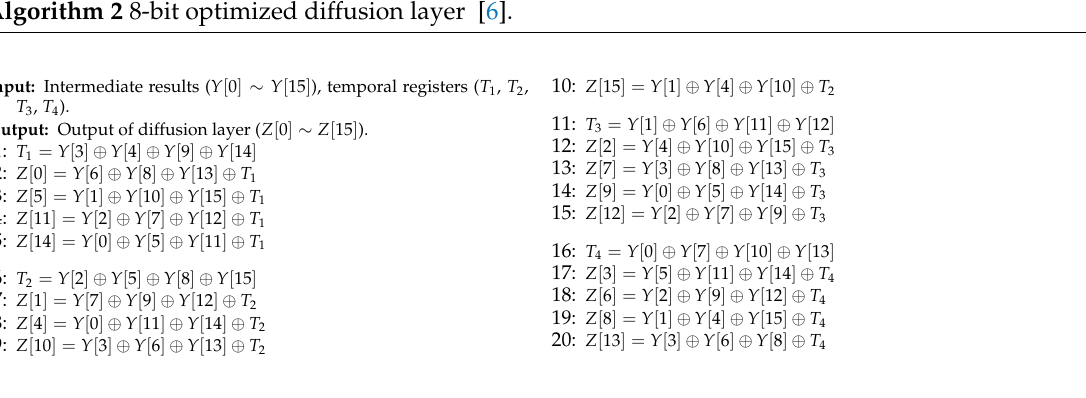
Algorithm 2 8-bit optimized diffusion layer